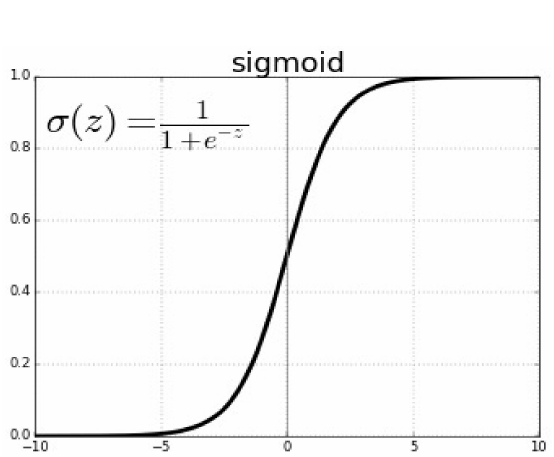
Figure 15. Sigmoid activation in the output